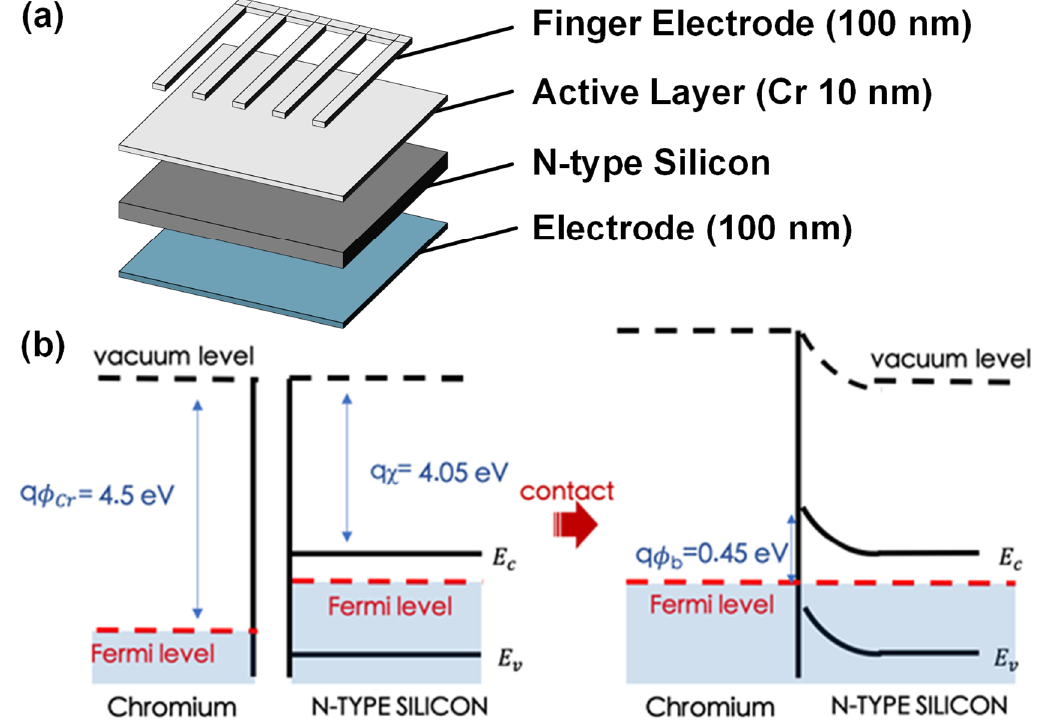
Figure 1. ( a ) The structure of the device; ( b ) the energy band diagram of the interface.